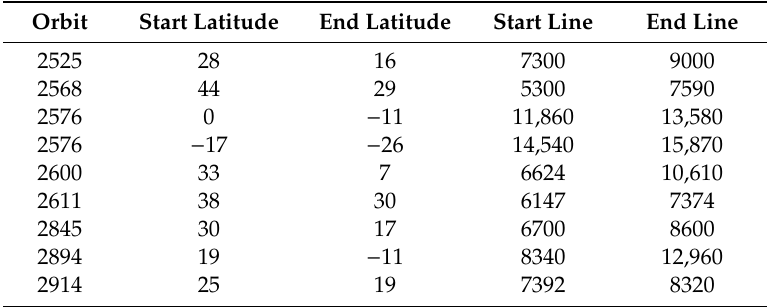
Table 2. Information of sample